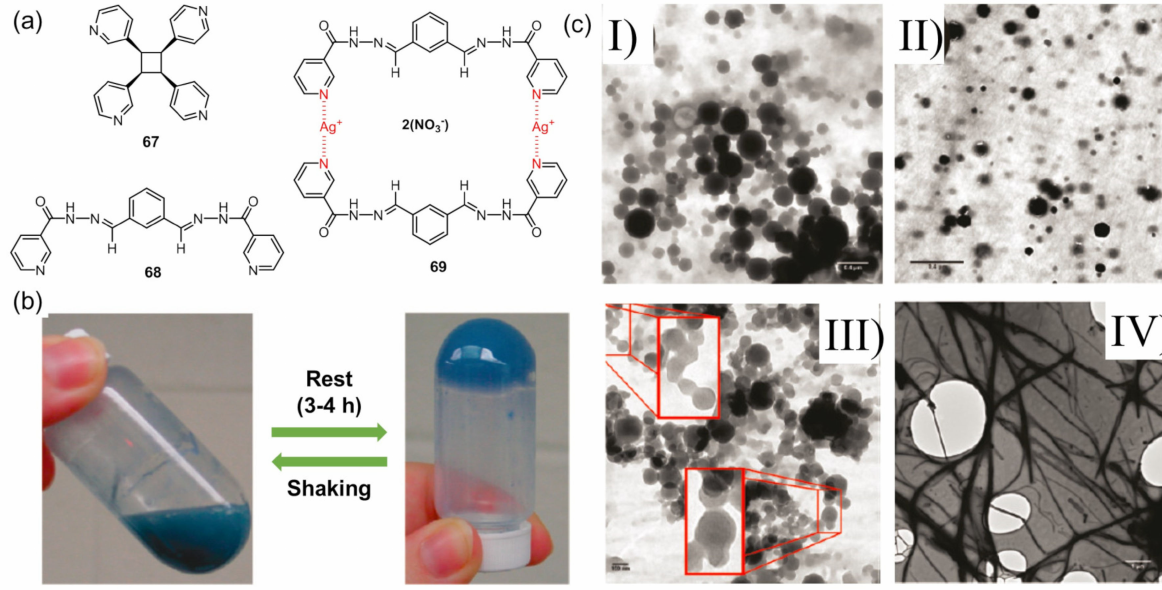
Figure 28. ( a ) Chemical structures of 67 - 69 . ( b ) Metallogels upon combining Cu(BF 4 ) 2 • 3H 2 O and 67 in water. ( c ) TEM micrographs of the hydrogel Cu-67 : (I) fresh gel upon standing (>4 h), (II) sol after shaking (5 min), (III) transition of NMOPs of reformed gel into “pearl-necklace” structures (in red) (3-6 weeks), and (IV) nanobundles in aged gels (about a year). Reprinted with permission from Ref. [98]. Copyright (2011), American Chemical